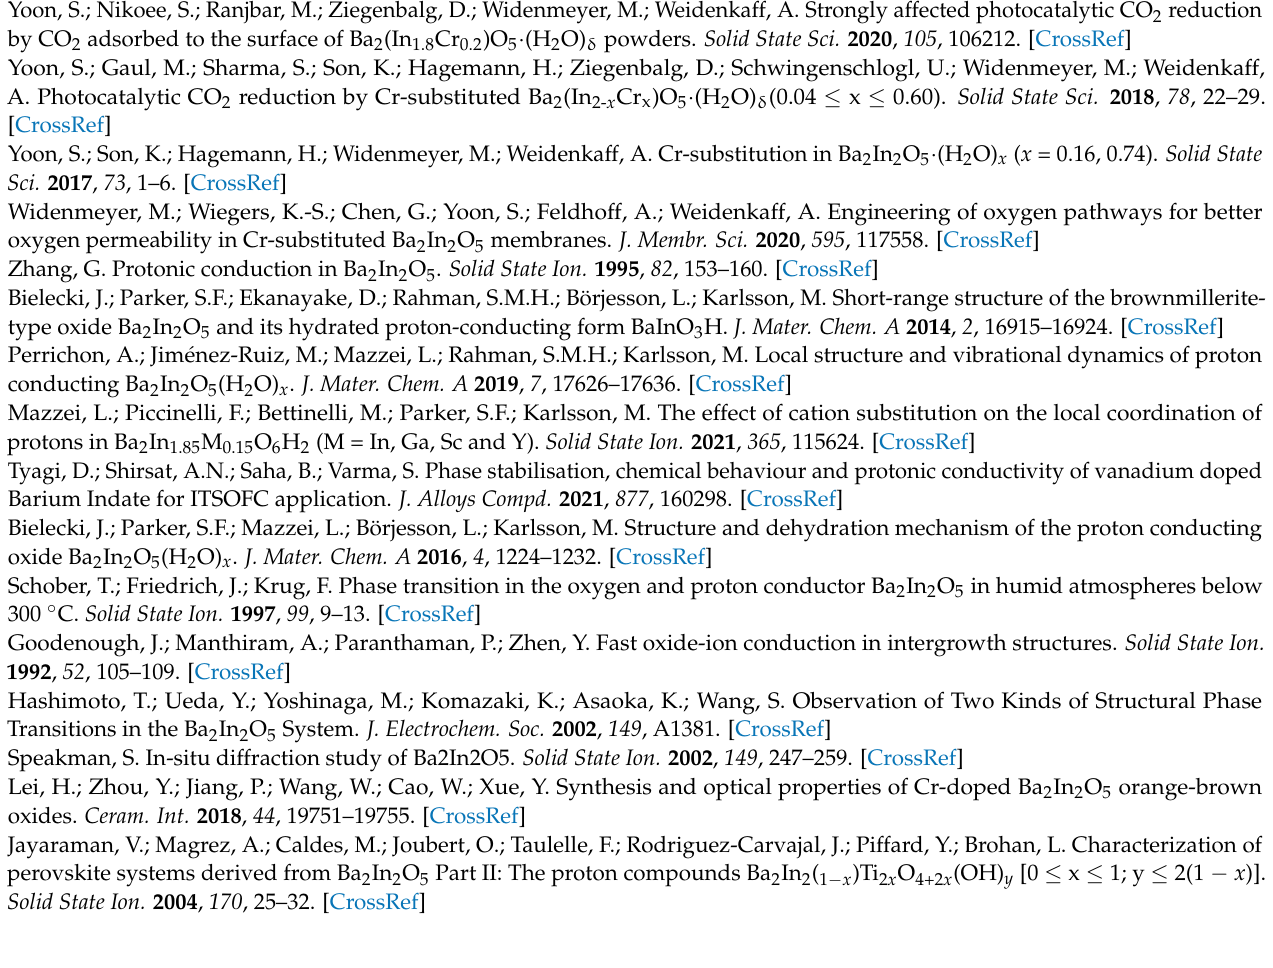
( I 4 cm , PND, D2B) at 293 K, Table S8: Structural data of Ba 2 In 1.8 Cr 0.2 O 4.74(8) ( I 4 cm , PND, D2B) at 10 K, Table S9: Structural data of BaIn 0.92(2) Cr 0.08(2) O 2.5 (first batch, PXRD) at 1123